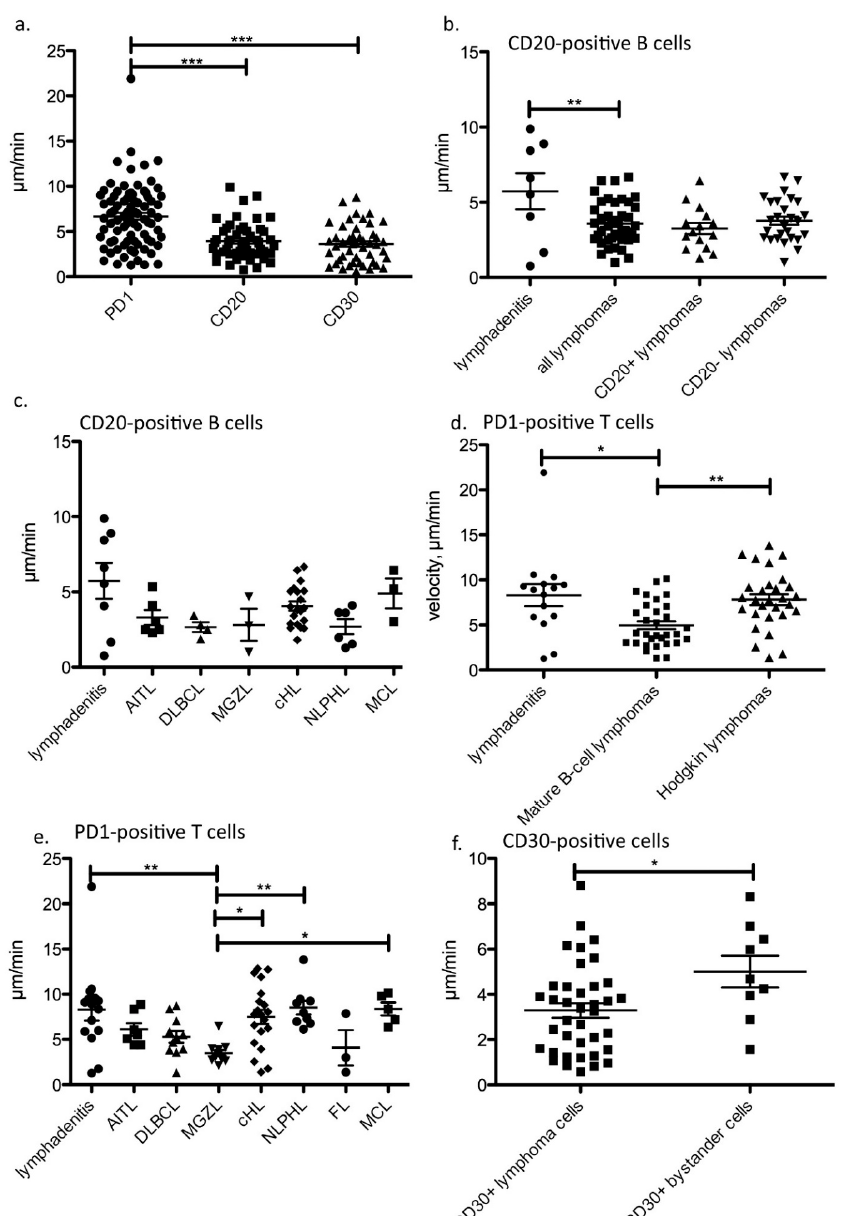
Figure 1. Velocity of different cell types under reactive and neoplastic conditions. ( a ). Velocity of PD1-positive T cells, CD20-positive B cells and CD30-positive cells in all cases studied (*** p < 0.001, one-way-ANOVA with Bonferroni’s post-test for multiple comparisons). Each dot represents the mean from one movie. ( b ). Velocity of CD20-positive B cells in lymphadenitis and malignant lymphomas. The velocity of bulk CD20-positive B cells in CD20+ lymphomas largely represents the velocity of tumor cells, whereas the velocity in CD20- lymphomas corresponds to reactive bystander B cells. (** p = 0.0042, unpaired t -test.) Each dot represents the mean from one movie. ( c ). Velocity of CD20-positive B cells listed according to different lymphoma entities. No significant differences were observed. Each dot represents the mean from one movie. Lymphadenitis: 4 cases, AITL, DLBCL and MCL: one case, MGZL and NLPHL: two cases, cHL: three cases. ( d ). Velocity of PD1-positive T cells grouped according to diagnosis of lymphadenitis, mature B-cell lymphomas and Hodgkin lymphomas. Each dot represents the mean from one movie. * p < 0.05, ** p < 0.01, Kruskal–Wallis test with Dunn’s post-test for multiple comparisons. ( e ). Velocity of PD1-positive T cells according to lymphoma entities. ** p < 0.01, *** p < 0.001, Kruskal–Wallis-Test with Dunn ´ s post-test for multiple comparisons. Each dot represents the mean from one movie. Lymphadenitis: 5 cases, AITL and MCL: one case, MGZL, DLBCL, FL and NLPHL: two cases, cHL: three cases. ( f ). Velocity of CD30-positive lymphoma cells compared with CD30-positive reactive bystander cells in CD30-negative lymphomas and lymphadenitis (* p < 0.05, unpaired t -test). Each dot represents the mean from one